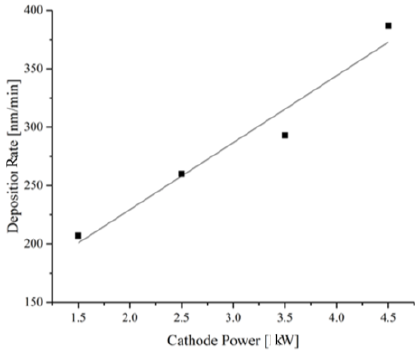
Figure 1. Relationship between the sputtering power and deposition rate of the Cr 2 AlC coatings.